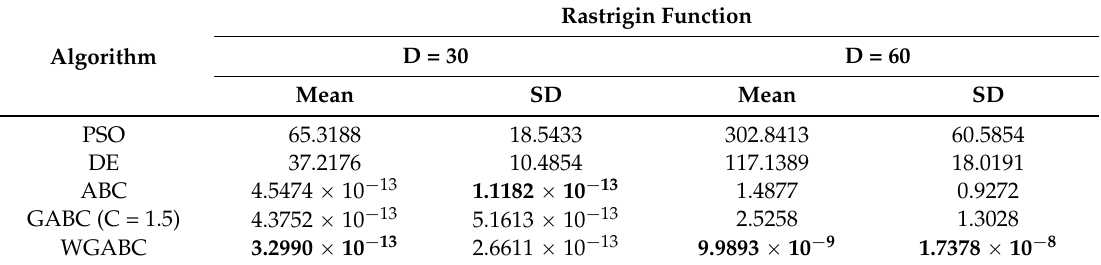
Table 5. The mean and standard deviation of the Rastrigin function on the different